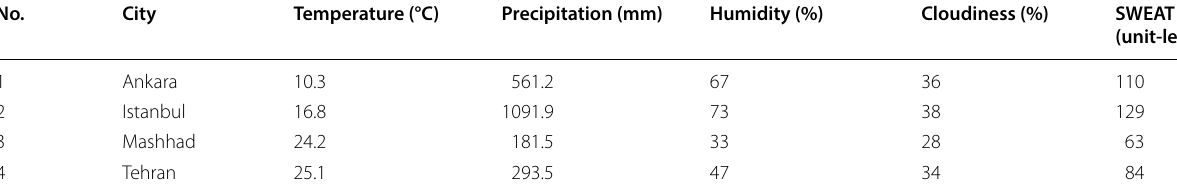
Table 4 Mean annual values of climatic independent variables in 2018 No.